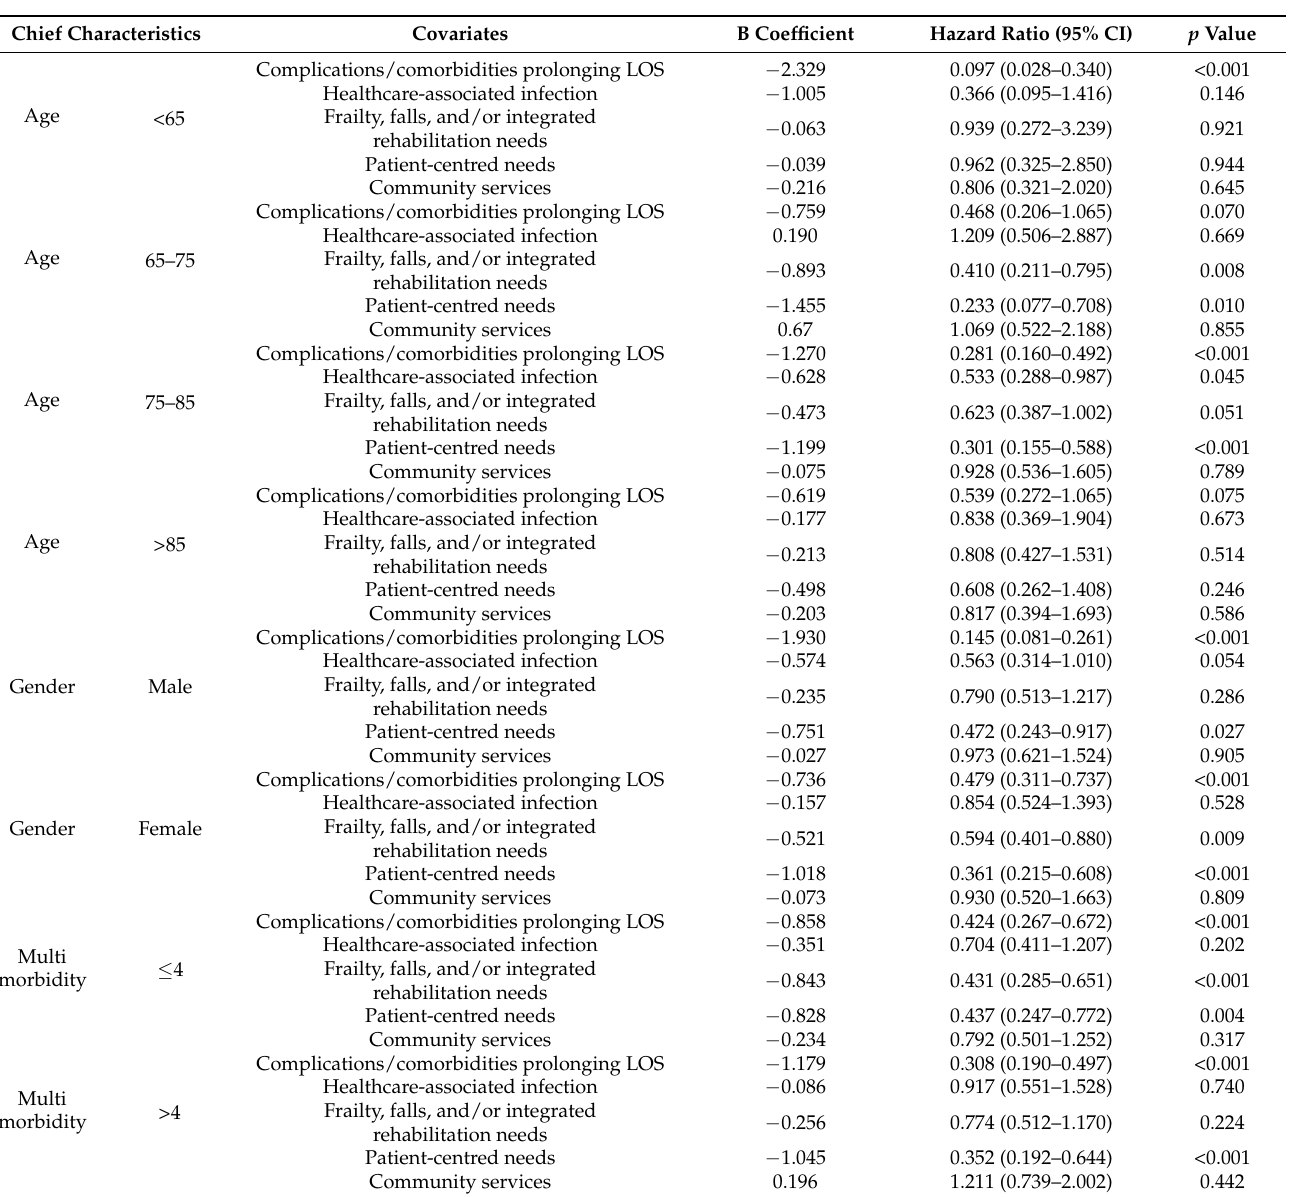
Table 2. Variables independently associated with delay in discharge (LOS, length of stay >15 days) from stratified Cox regression